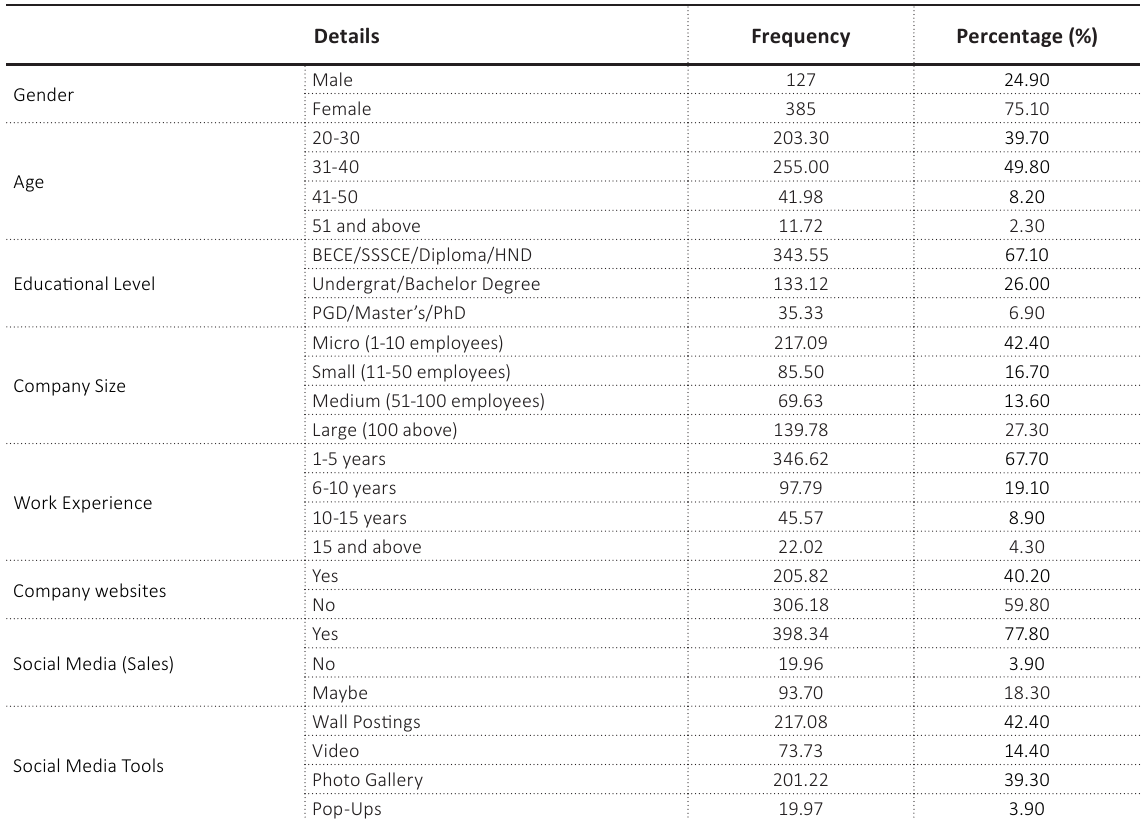
Table 1. Demographic